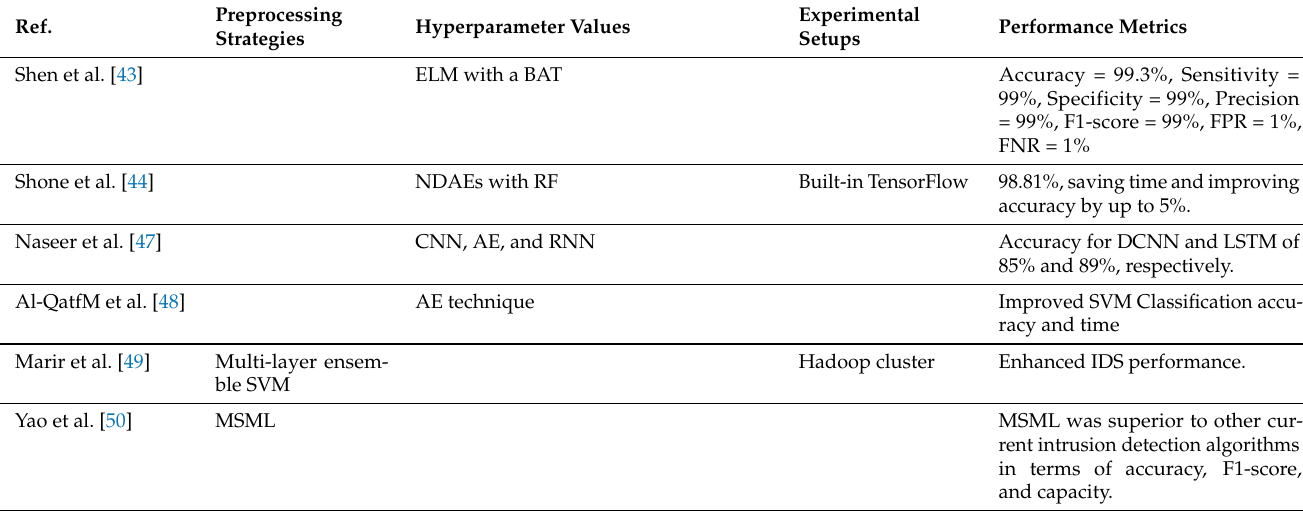
Table 5. The most recent studies on DDoS attack detection using